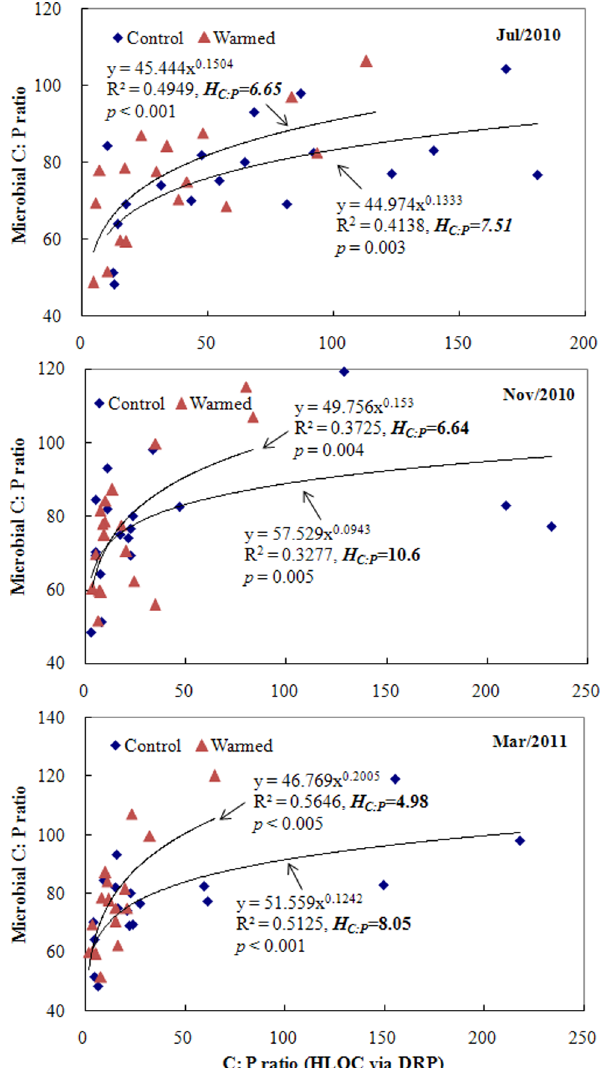
Figure 2. Relationships between soil microbial phosphorus (MB-P) content and dissolved reactive phosphorus (DRP) in porewater. Control and Warmed represent treatments of ambient temperature and ambient temperature + 5 u C, respectively. Coefficients fitting the data to the equation for stoichiometric homeostasis are given along with an estimate of H P .